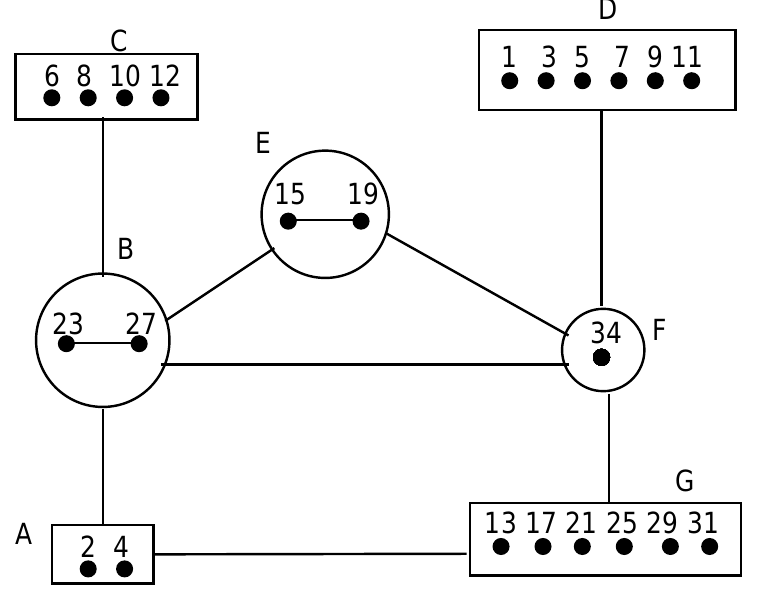
Figure 2. The vertex labels of Γ ( Z p 2 × Z q 2 ) , for p = 3 and q =